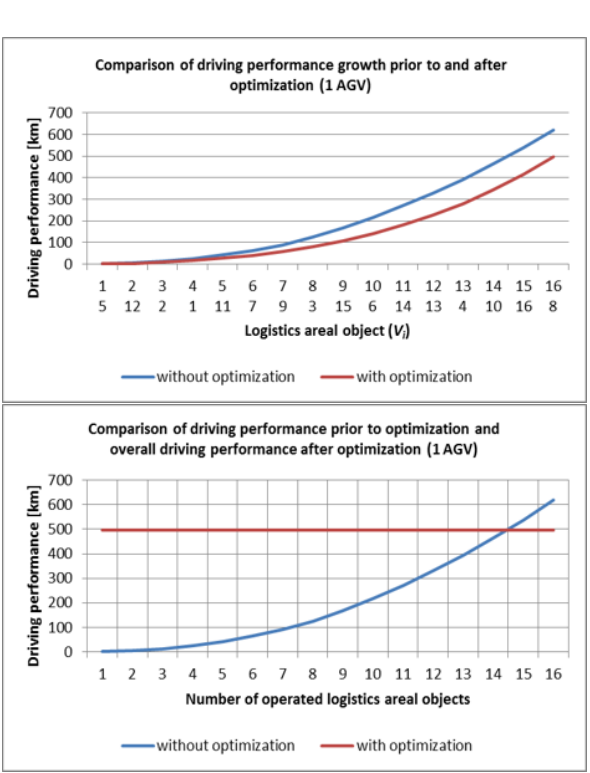
Figure 2: Graphical representation of driving performance prior to and after the distance optimization when using single AGV